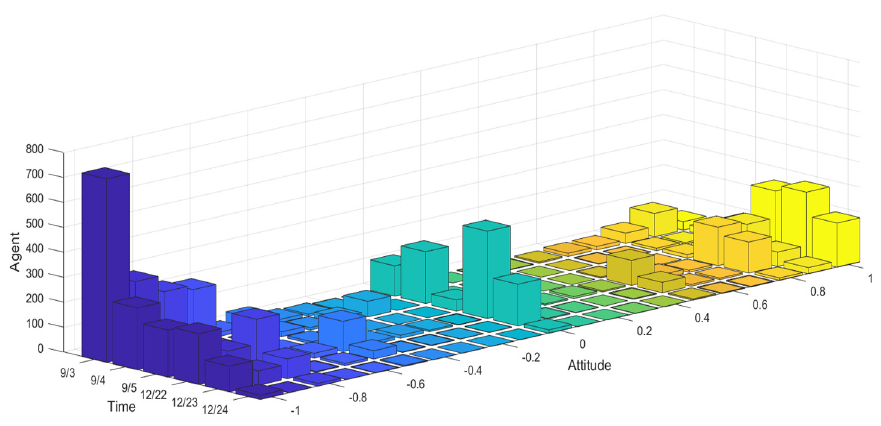
Healthcare 2020 , 8 , x Figure 29. Diagram of public opinion evolution. Figure 29. Diagram of public opinion evolution.